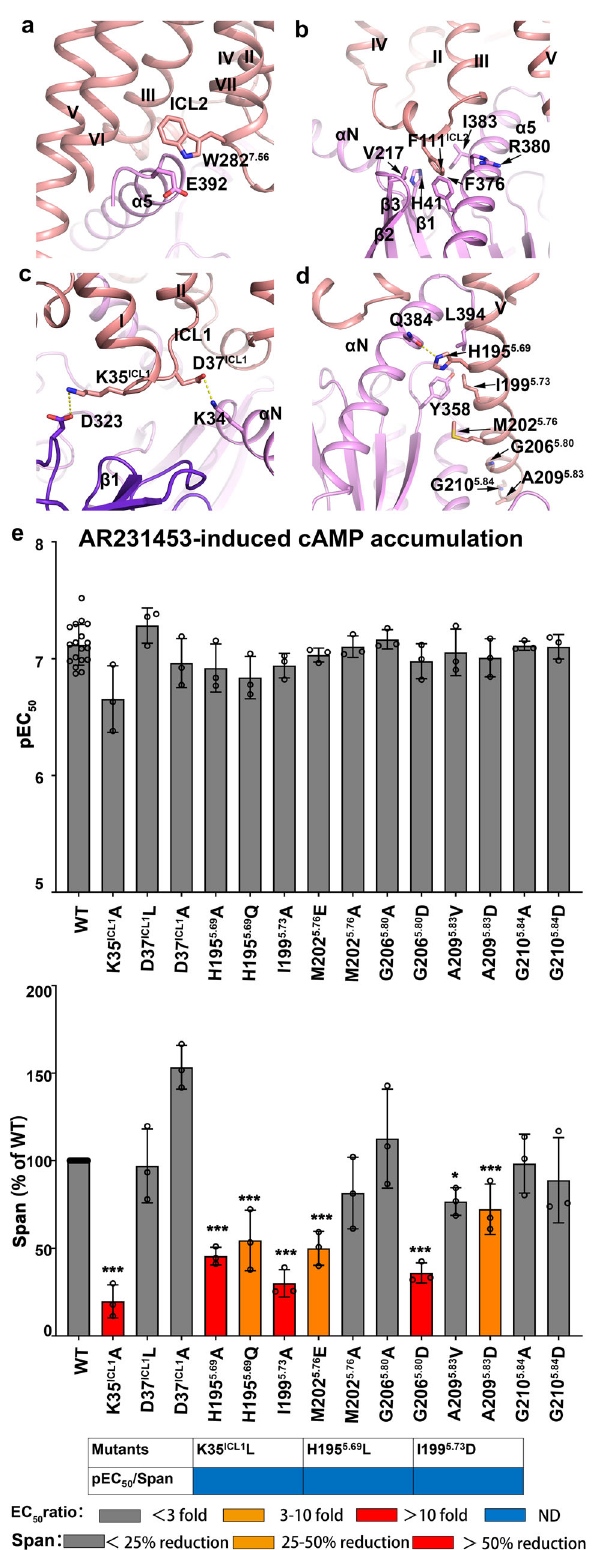
GPR119 to form the major interaction interface with residues from TM3, ICL2, TM5, TM6 and TM7 of the receptor (Fig. 4a). Notably, E392 at the C-terminus of α 5 helix of the G α S subunit forms a stacking interaction with W282 7.56 at TM7 of GPR119, which was not observed in the structures of other class A GPCR-G s complex, including β 2-